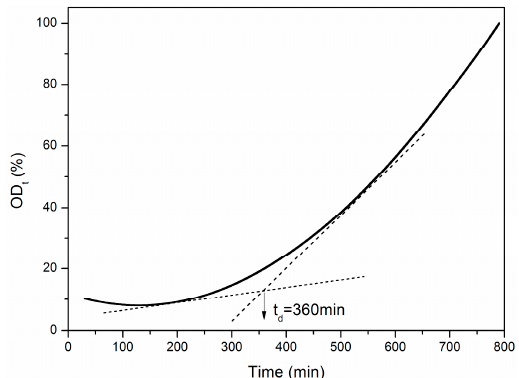
Figure 15. Variation of tensile modulus with the exposure time .